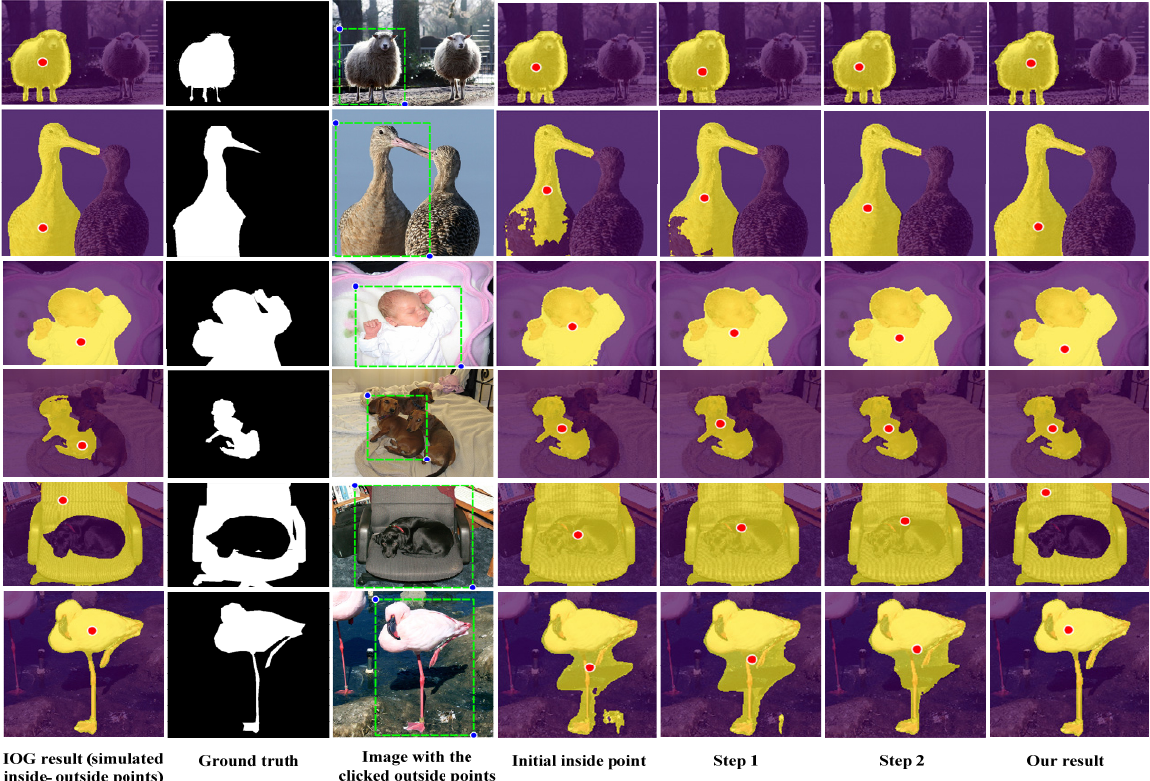
Sensors 2021 , 21 , x FOR PEER REVIEW 10 of 15 Figure 5. The training error curve trained on PASCAL-10k datasets. 4.3. Interactive Segmentation Results First, we evaluate the performance on PASCAL VOC val set to validate the effective- ness of our IPL-Net. We set the geometric center of the cropped image as the initial posi- tion of the inside point. Figure 6 shows sequences of segmentation results and the inside point in first two steps and the final step. As shown in Figure 6, the results show that the segmentation performance is significantly improved when the inside point moves accord-